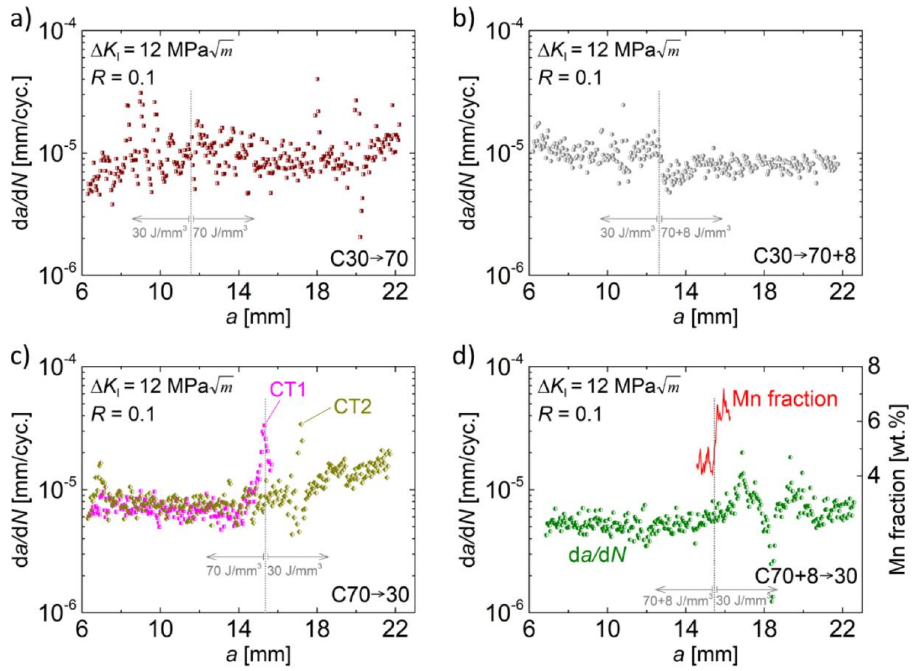
Figure 5. Crack growth rates d a /d N versus crack length a for the graded specimens of material states C30 → 70 ( a ), C30 → 70 + 8 ( b ), C70 → 30 ( c ), and C70 + 8 → 30 ( d ) at a cyclic stress intensity factor √ of 12 MPa m. The vertical grey dotted lines indicate the gradation obtained from light microscopy of fracture surfaces. ( c ) includes two specimens marked by CT1 and CT2 and in ( d ) the manganese fraction for a limited crack length segment as determined by an EDS line scan is